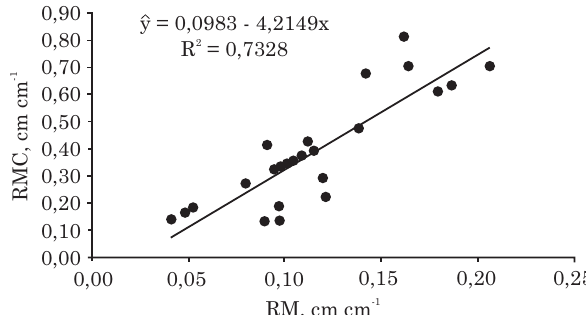
Figura 4. Dispersão entre as duas formas de cálculo do RM, variando o valor de Ds utilizado pela média de Ds dos solos e usando o valor de 1,5 Mg m -3